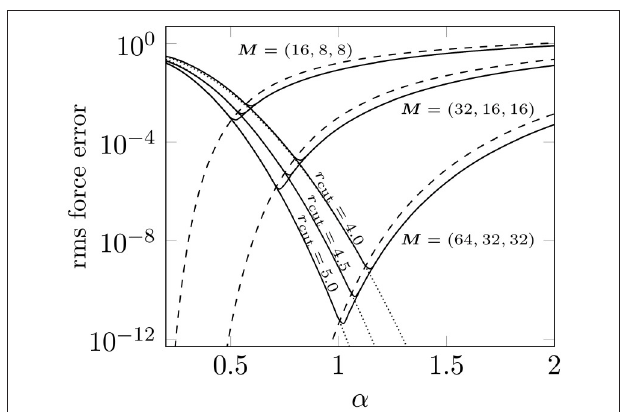
FIGURE 1 | Achieved rms force errors (solid) for different far field cutoffs M and different near field (2 M , M , M ) with M 8 , 16 , 32 = ∈ { } cutoffs r cut . We also plot the estimates for the rms force 4.0 , 4.5 , 5.0 ∈ { } error in the near field (dotted) as well as for the far field with elliptical cutoff (dashed), see Equations (28) and (31). Test case: N 600 randomly = distributed particles in a box with edge lengths L (20 , 10 , 10) =